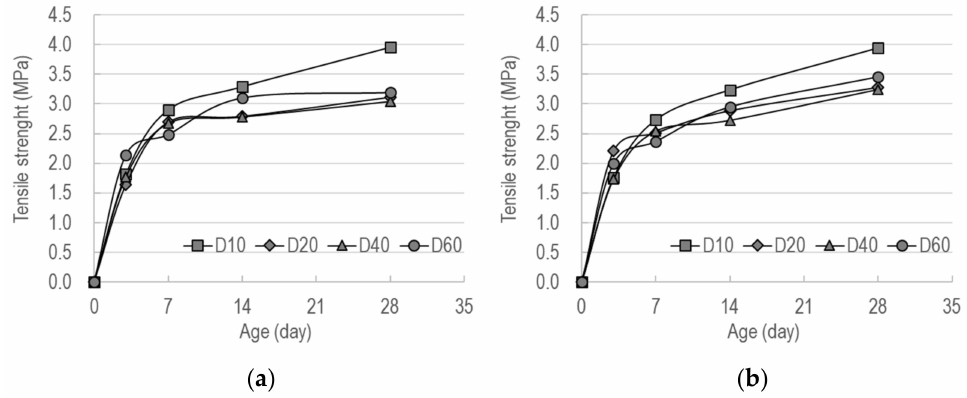
Figure 5. Split tensile strength histories: ( a ) W170 mixtures and ( b ) W160